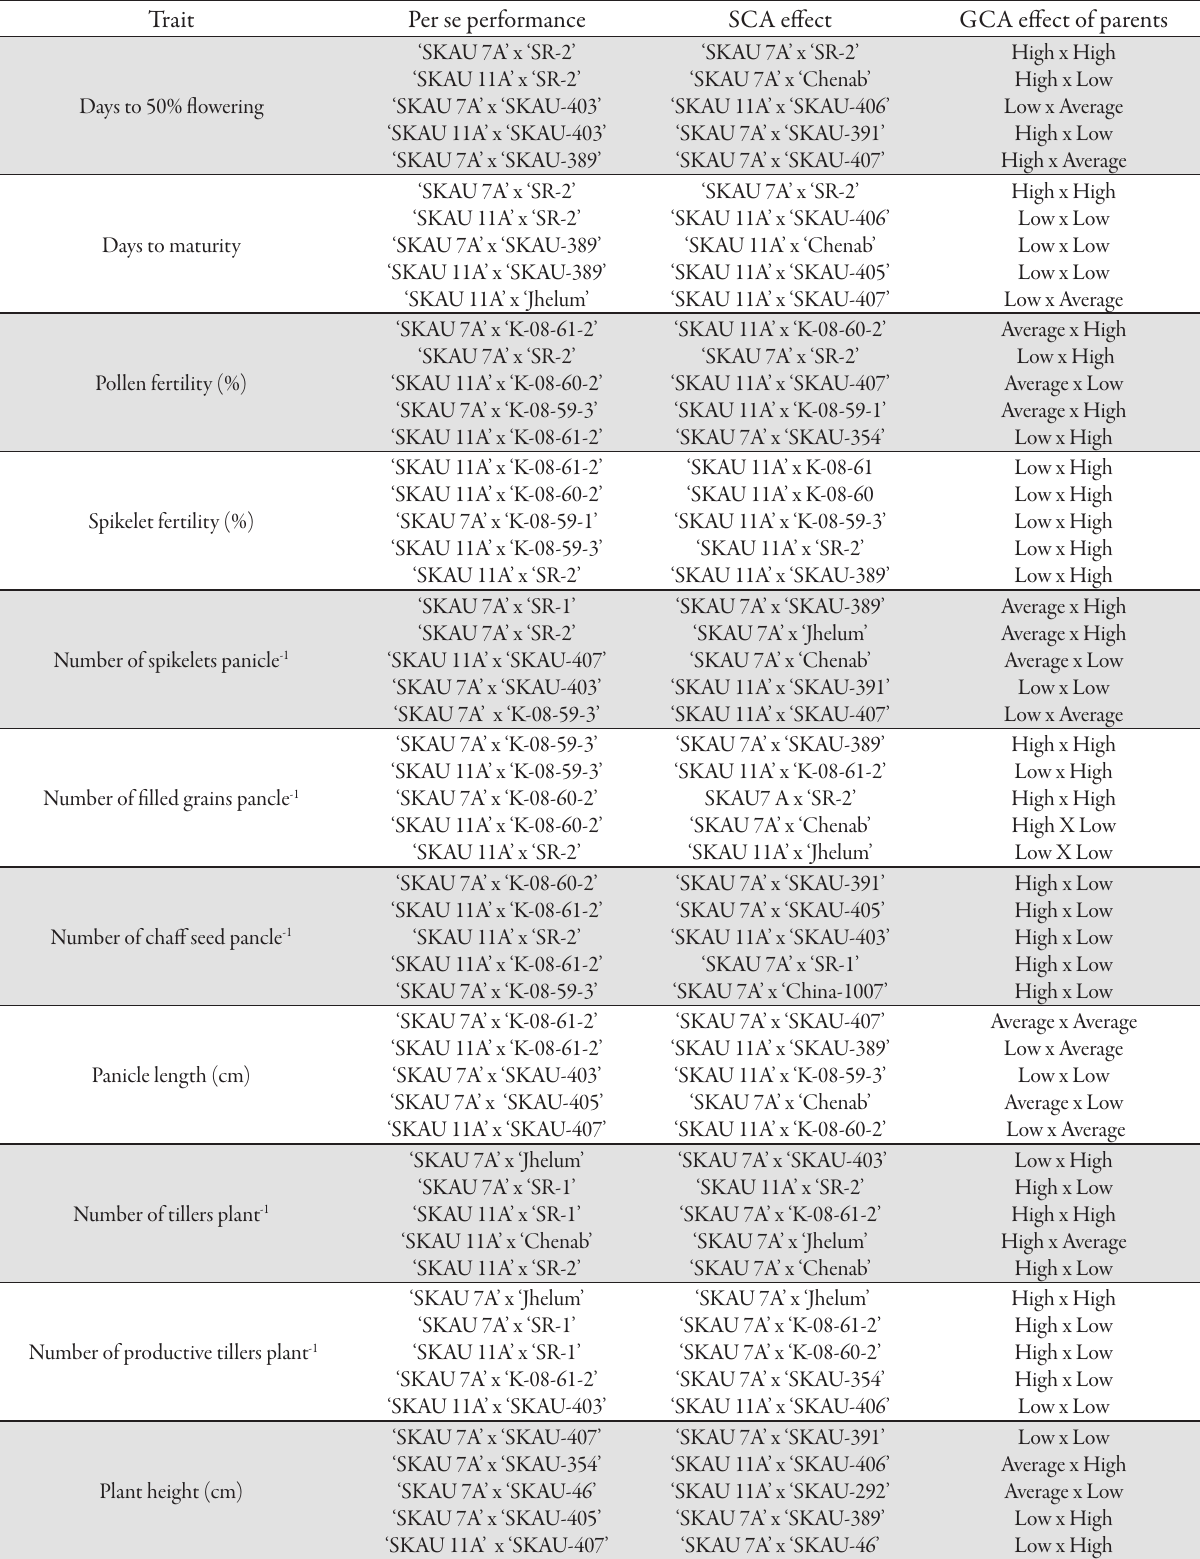
Tab. 7. Top ranking of specific cross combinations for different traits on the basis of SCA, per se , and GCA of parents involved in